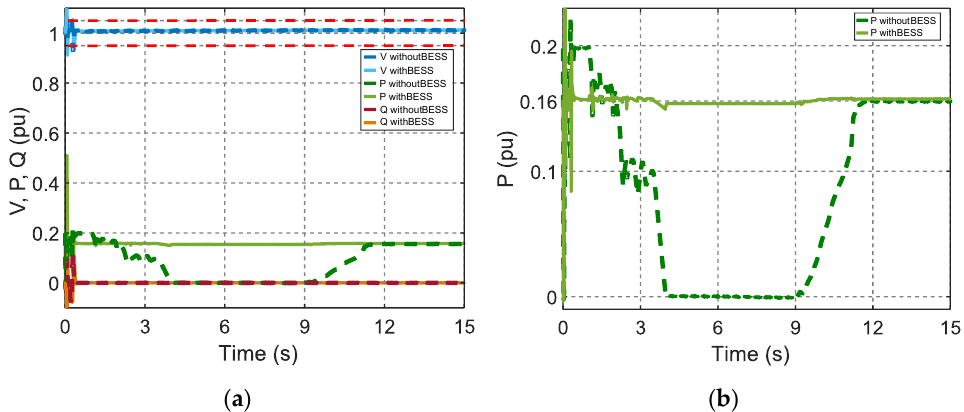
Figure 18. Solar plant with BESS and without BESS: ( a ) voltage (V), active power (P), and reactive (Q) power; ( b ) active power (zoom).